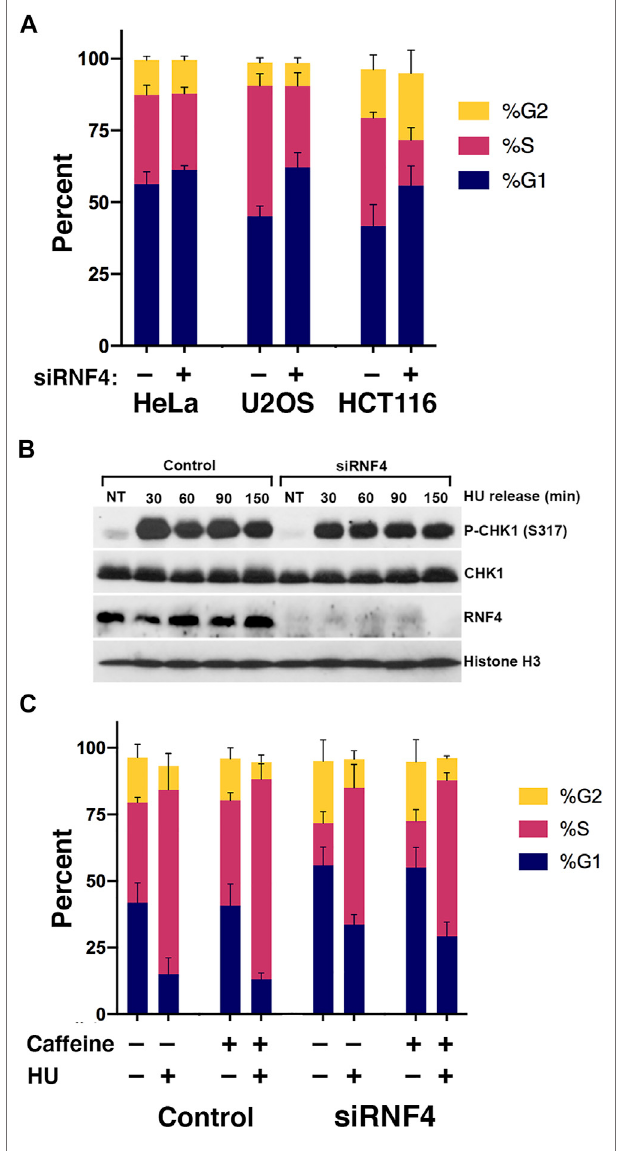
FIGURE 2 | RNF4 depletion was associated with a cell cycle defect. (A) RNF4-depleted cells exhibited increases in fraction of cells in the G1 phase and decreases in fraction in S phase. Cell cycle distributions were determined by incorporation of BrdU for 20 min, anti-BrdU and propidium iodide staining, followed by fl ow cytometric analysis. Results of three independent experiments were averaged and standard deviations shown. (B) RNF4- depleted U2OS cells exhibited similar levels of CHK1 phosphorylation (Ser317) with or without treatment with 2 mM HU for 16 h. Levels were also measuredincellsblockedinHUfor16 hthenreleasedintonormalmediumfor various times. (C) RNF4-depleted HCT116 cells exhibited similar cell cycle distributions compared to control-depleted cells with or without treatment with HU, caffeine, or both. Results of three independent experiments were averaged and standard deviations